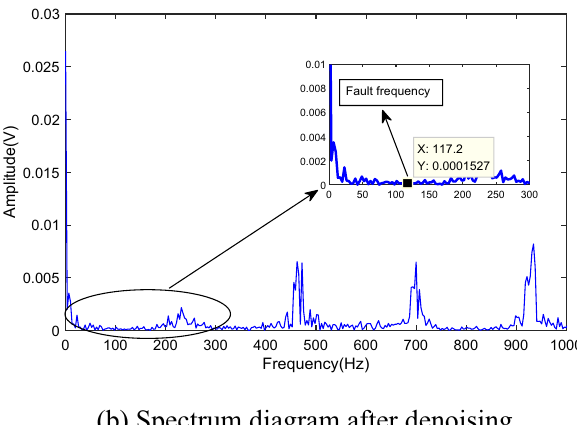
(a) Waveform after noise reduction